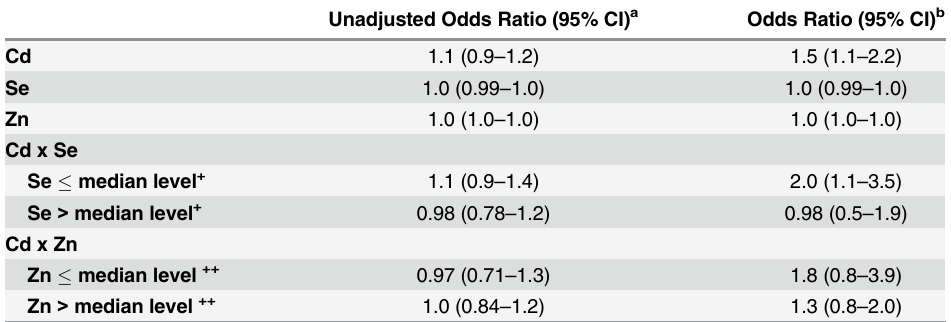
Table 3. Odds ratios and 95% Confidence Intervals (CI) for preeclampsia in relationship to placental Cd, Se or Zn and interactive models for Cd with essential metals Se and